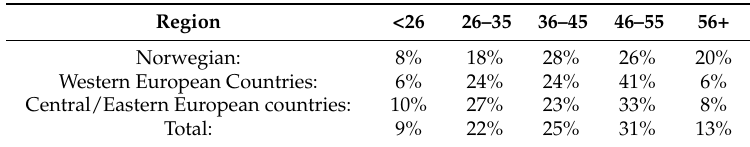
Table 2. Age groups of the drivers, according to their nationality group. Per cent. Norwegian (N = 61), Western European country (N = 17), Central/Eastern European country (N = 52).